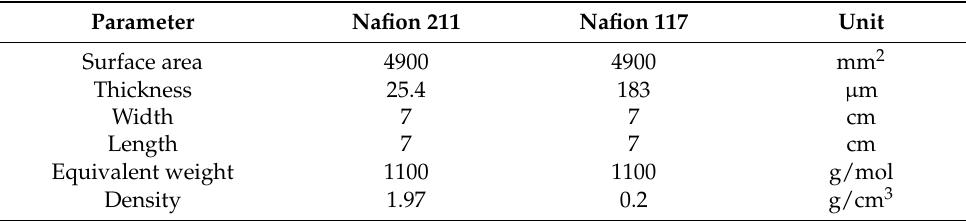
Table 1. Specification of the Nafion 117 and Nafion 211 membrane used in the experiment.